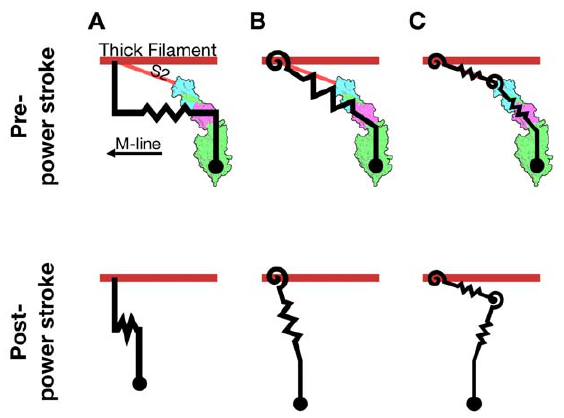
Figure 7. Changes in cross-bridge resting geometry with the power stroke. (A)–(C) show, schematically, the change in the rest lengths and angles of the single and multi-spring cross-bridges. The rest length and angle of the 2sXB’s extensional and torsional springs are set, in both the pre- and post-power stroke states so as to match the tip position of the 2sXB in each condition to that of the 4sXB (in Table 1). The change in the unstressed radial distance from the thick filament to the tip of the multi-spring cross-bridges that occurs with the power stroke is particularly visible in (B) and (C) when compared to the single spring cross-bridge (A). The effects of the universal joint attaching the springs of the 4sXB and the 2sXB to the globular domain, and the globular domain’s own fixed angle to the thin filament, are shown by the continued radial orientation of the globular domain after the power stroke